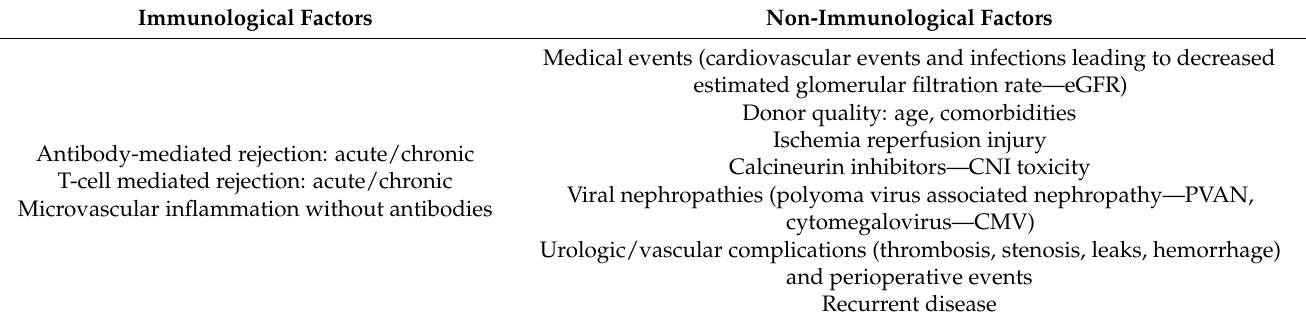
Table 1. Traditional immunologic and non-immunologic risk factors for allograft loss (Adapted from ref.